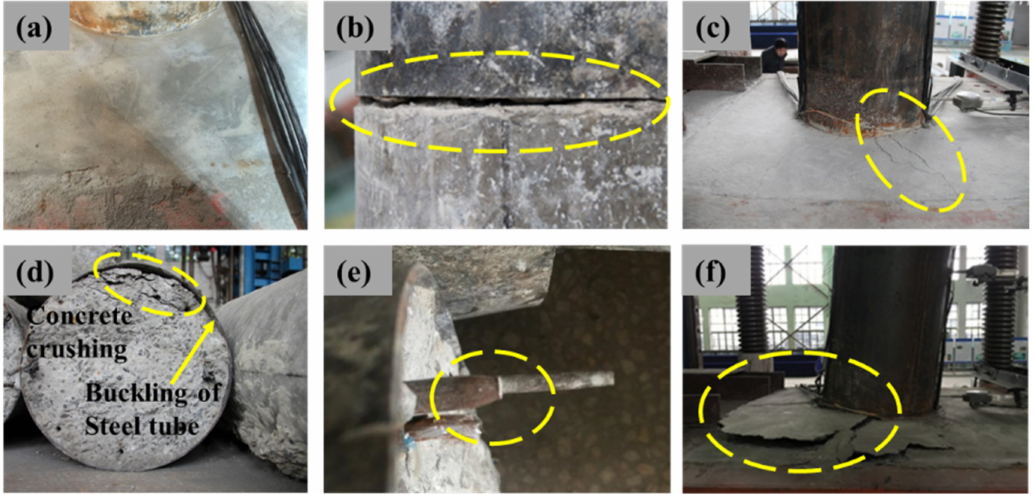
Figure 4. Failure characteristics of specimens: ( a ) Event A; ( b ) Event B; ( c ) Event C; ( d ) Event D and E; ( e ) Event F; ( f ) Event